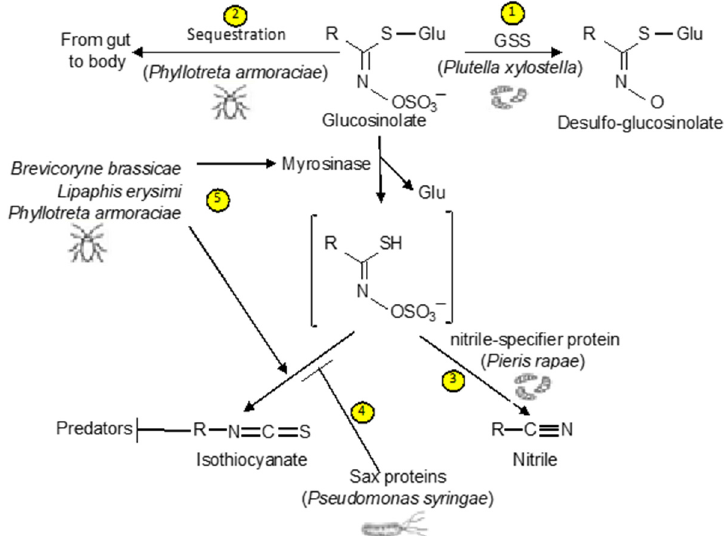
Figure 5. Mechanisms by pests and pathogens to counter or exploit the glucosinolate–myrosinase system. These mechanisms include inactivation of glucosinolates by glucosinolate sulfatase (GSS) (1) or sequester glucosinolates from the gut to the body (2). Other pests rely on nitrile-specifier proteins to redirect the glucosinolate hydrolysis from isothiocyanates, which are highly toxic, toward nitriles, which are less toxic (3). Bacterial Pseudomonas pathogens also use Sax proteins to reduce isothiocyanate formation (4). Some adapted specialist insects sequester glucosinolates and convert these glucosinolates to toxic products by using their own myrosinase for defense against predators (5).